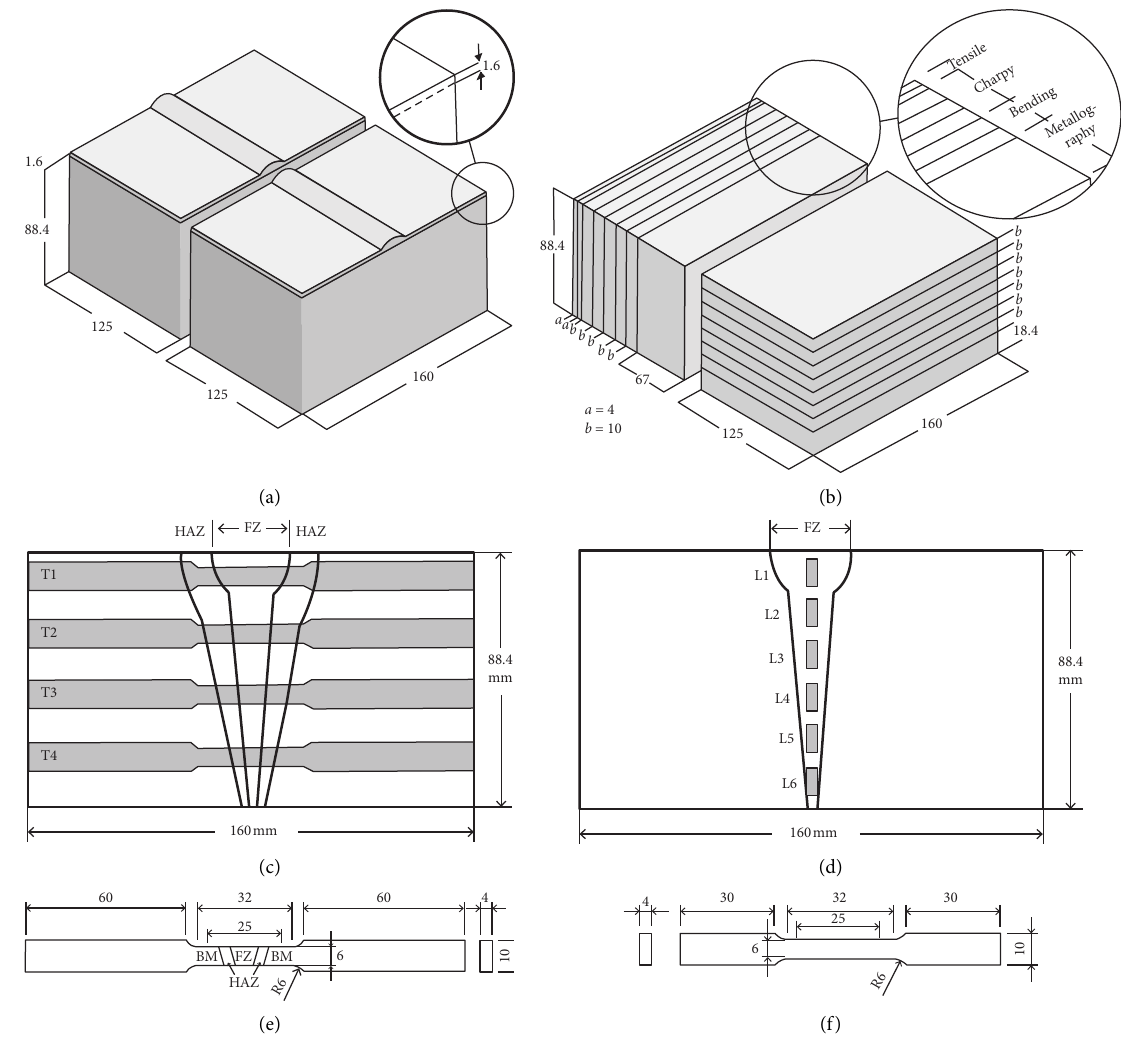
Figure 2: Schematic of the sampling steps after residual stress measurement: (a) top surface removal and (b) EDM to extract metallography, tensile, Charpy impact, and bend samples. Tensile sampling in the (c) transverse direction and the (d) longitudinal direction with the corresponding geometry for the (e) transverse and (f) longitudinal samples (units in